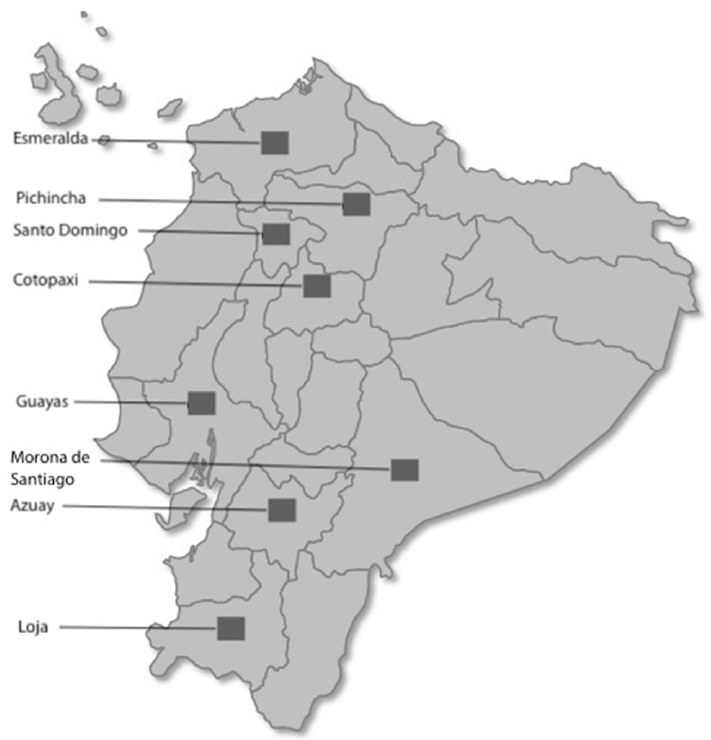
Figure 1. Distribution of the data-collection areas in Ecuador.